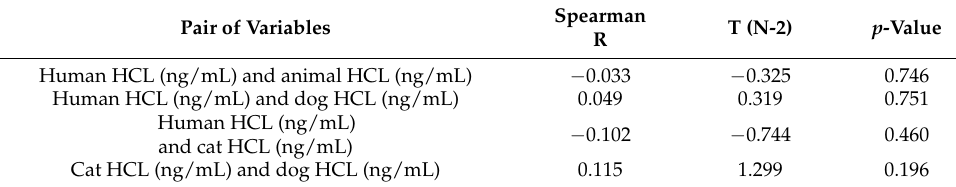
Table 2. Spearman Rank Order Correlations for human and animal hair cortisol levels (HCL). Spearman Pair of Variables